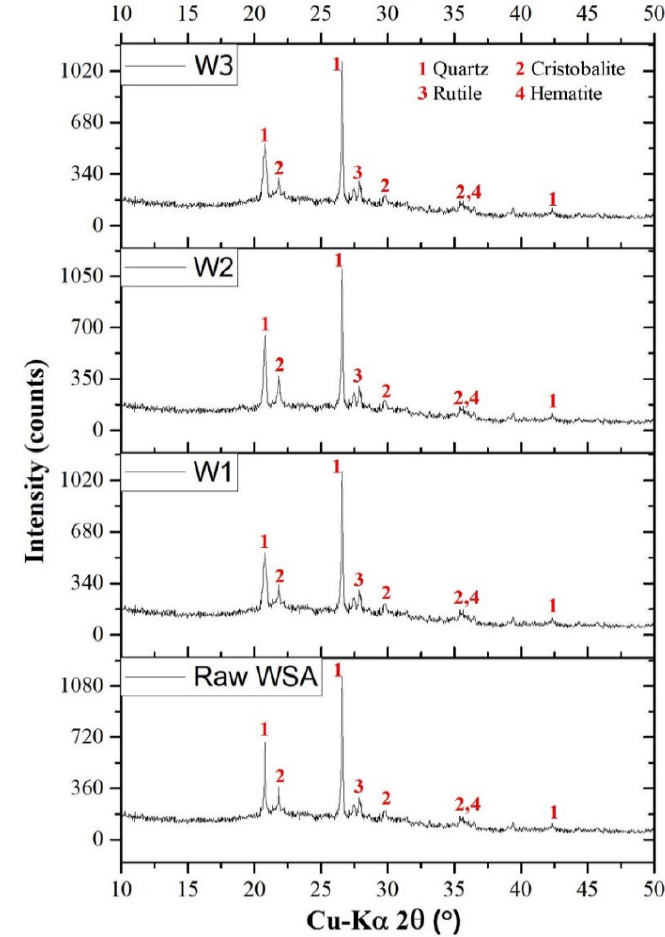
Figure 2. XRD pattern of WSA specimens.